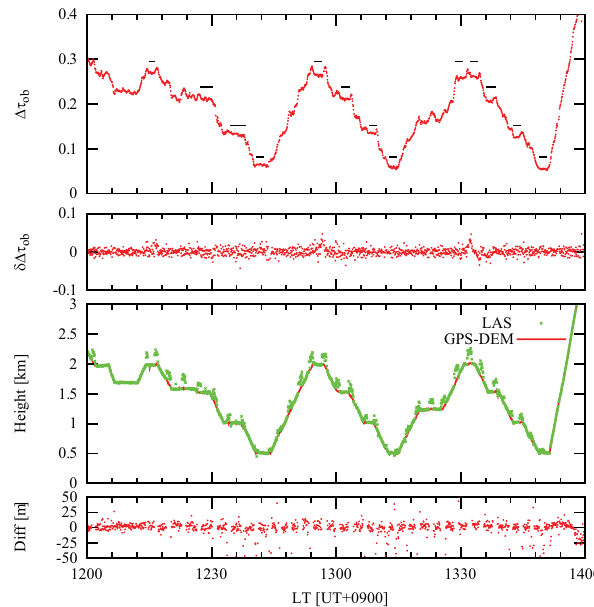
Fig. 6. Results of airborne flight measurements taken on 23 Febru- ary 2010. These data were taken over the Tsukuba site (urban area). Some data points that lie off the validation data resulted from im- perfect correction of the viewing angle. These uncorrected data are excluded when the altitude accuracy and XCO 2 are evaluated.